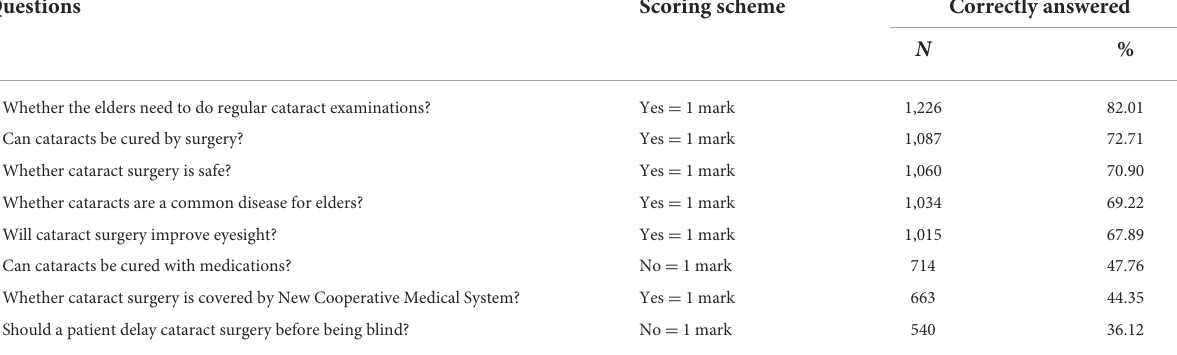
TABLE 3 Knowledge about cataracts among adults aged 50 and above in rural Western China ( n = 1,495).